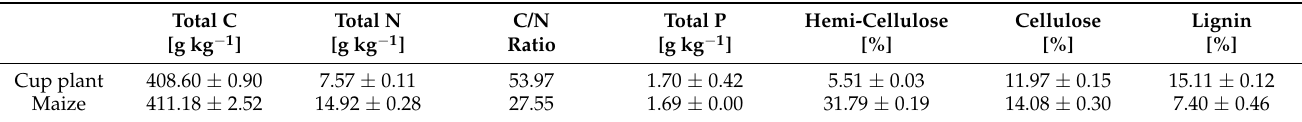
Table 1. Initial total C and N content [g kg − 1 ] and total P [g kg − 1 ] and plant structural substances hemicellulose, cellulose and lignin [%] of dried maize and cup plant litter (mean ± SE).